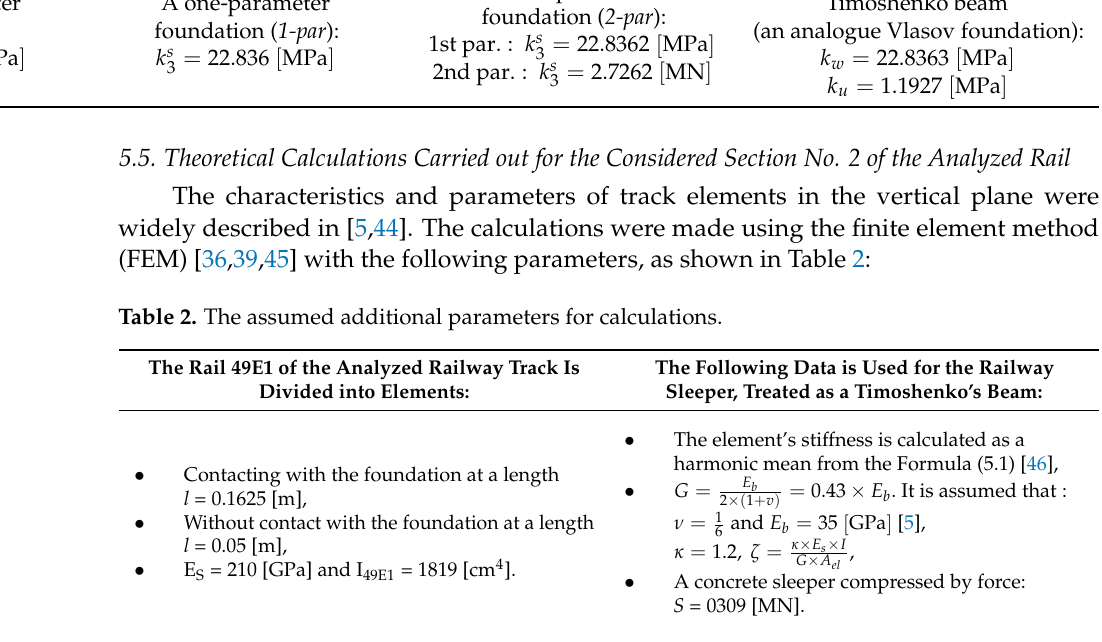
Table 1. Obtained values of the foundation parameters for the theoretical calculations (according to scheme from Figure 3). For a Rail For a Sleeper For a Sleeper For a Sleeper A one-parameter foundation: